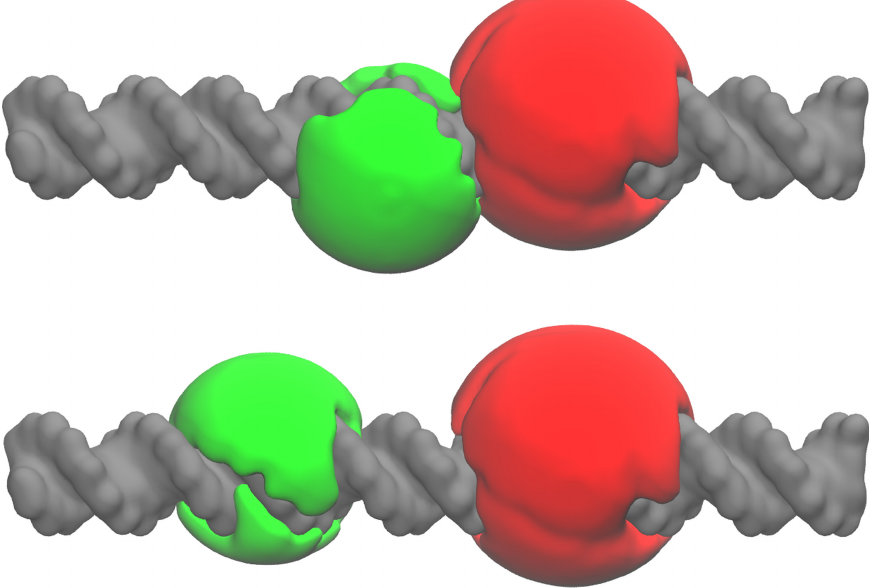
Figure 5. Surface representations of the calculated accessible volumes (AVs) for the 10-bp DNA ( top ) and the 17-bp DNA ( bottom ) structure. The AVs of the donor (T-C6-Alexa488) and the acceptor (T-C6-Alexa647) dye-linker constructs are displayed in green and in red, respectively. Although the size of the volumes can vary to a certain extend with parameters, such as the linker thickness, the results presented here are not significantly affected by them. A partial overlap between the AV clouds is observed for 10 bp DNA. The DNA structures were generated on the 3D-DART web server [30]. The representations were created with VMD